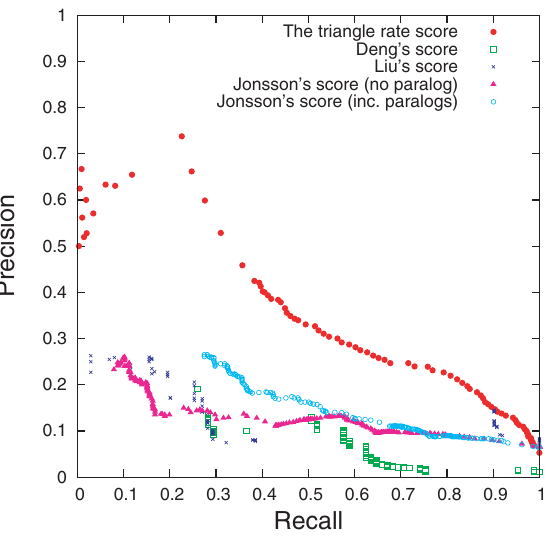
Figure 3. P-ROC Curves for Comparison among Scores. The P- ROC curves for the comparison of